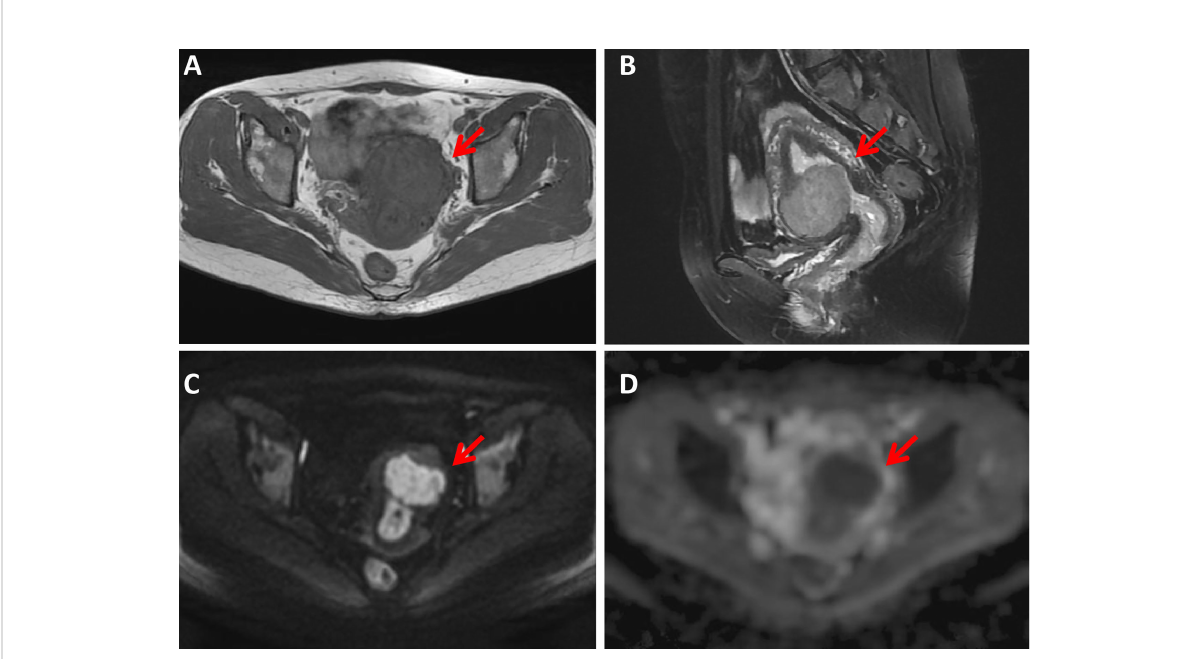
FIGURE 2 A 43-year-old woman with a cellular leiomyoma. A mass was located in the uterine anterior wall (arrow) with a clear margin, showing isointensity on T1WI (A) and hyperintensity on T2WI images (B) . This mass showed high signal intensity on diffusion-weighted MR image (C) with